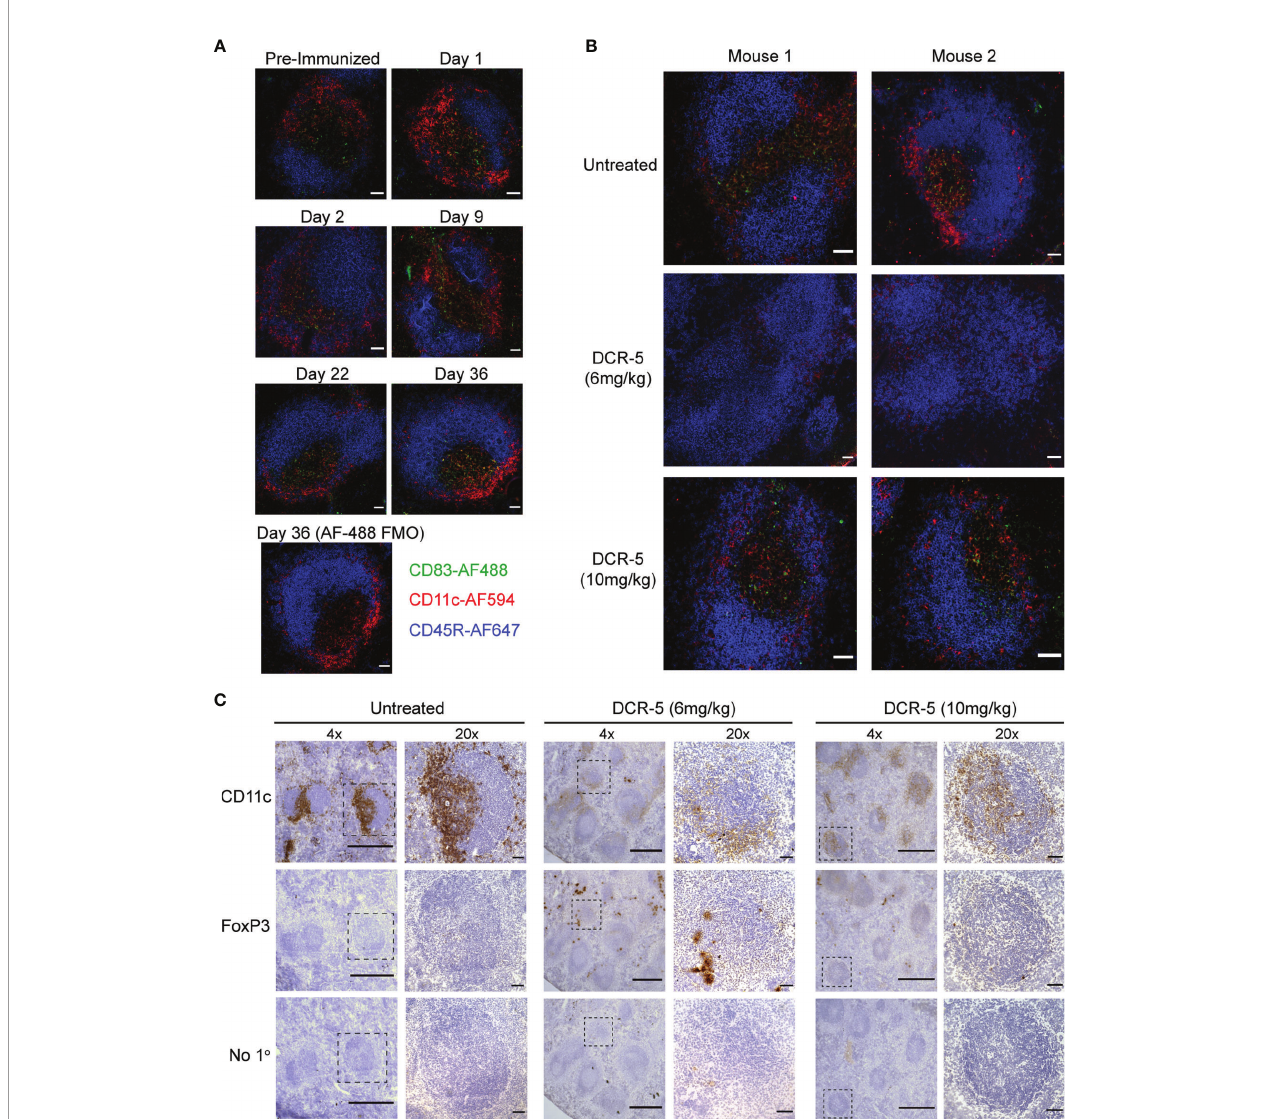
FIGURE 10 | DCR-5 treatment decreases CD11c staining and increases FoxP3 staining in spleens of CIA mice. (A, B) Immuno fl uorescence histology of splenic follicles showing CD83 detected with biotinylated Michel-19 clone together with CD11c and B220 marking DC and B cells, respectively. (A) Shows representative ×20 images from one of two DBA/1 mice euthanized pre-immunization or on the indicated days post-immunization of collagen. A control stain omitting the anti-CD83 primary antibody but including the Streptavidin-AF488 secondary is shown. Scale bars mark 50 µm. (B) Shows representative ×20 images of splenic follicles from two of four mice from untreated, 6 mg/kg or 10 mg/kg DCR-5 treated groups described in Figure 9 . Scale bars mark 50 µm (C) Immunohistochemistry of adjacent spleen sections stained with biotinylated CD11c, FoxP3 antibodies or secondary streptavidin-HRP only. Representative ×4 image and marked inset at ×20 from one of four mice in untreated, 6 and 10 mg/kg DCR-5 treated groups are shown. Scale bars mark 500 and 50 µm in ×4 and ×20 photographs,